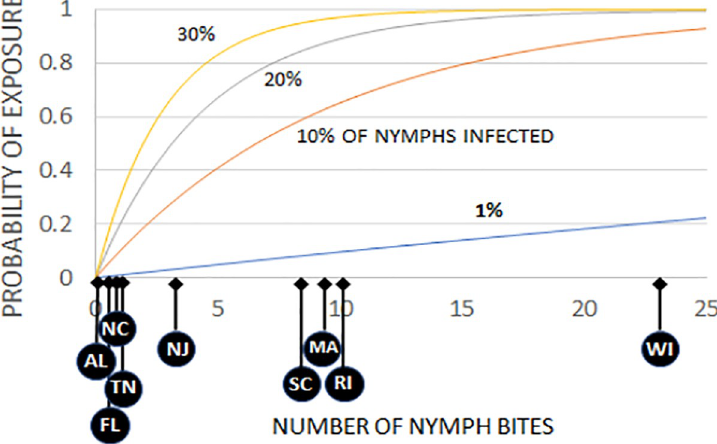
Fig 6. Probability of exposure to spirochetes for mice bitten by varying numbers of nymphal ticks. Probabilities calculated for different levels of infection prevalence in ticks. Approximate yearly numbers of nymphs per mouse over the season at the 8 primary field sites (2011–2012) and at Rhode Island (2012) indicated below horizontal axis. Data are available in S9 Data.